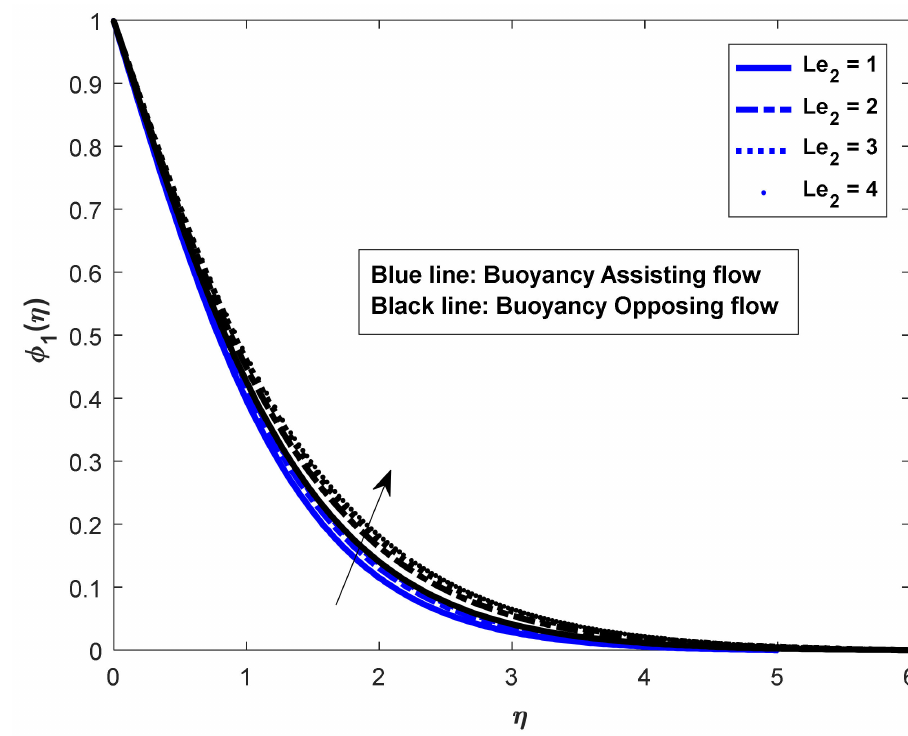
Figure 19. Le 2 on salt_1